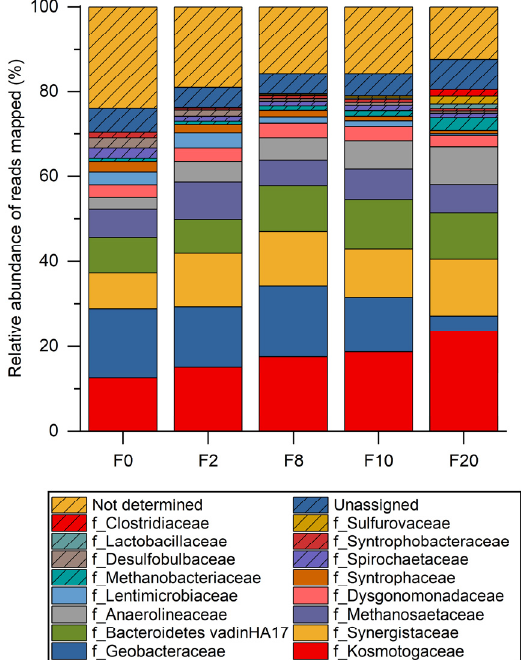
Figure 9. Relative abundance of reads mapped to ASVs at family taxonomic level for bioreactor fermentation samples. Samples were collected on days 0, 2, 8, 10, and 20 of the fermentation. The “Unassigned” category corresponds to reads mapped to ASVs assigned to families with a percentage of reads below 1% in any of the samples.